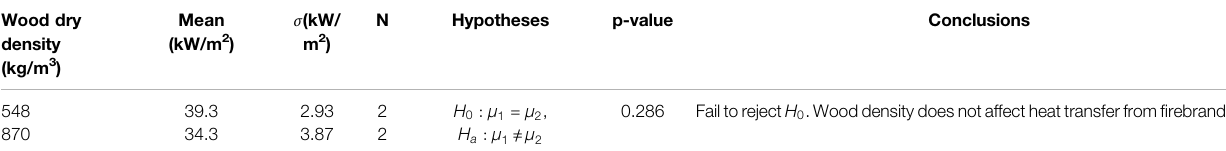
shows that the fourth order interaction between length, diameter, mass, and wind (ABCD) does not appear to be important. The